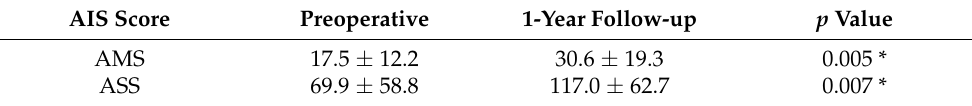
Table 4. Preoperative and 1-year follow-up AIS score.